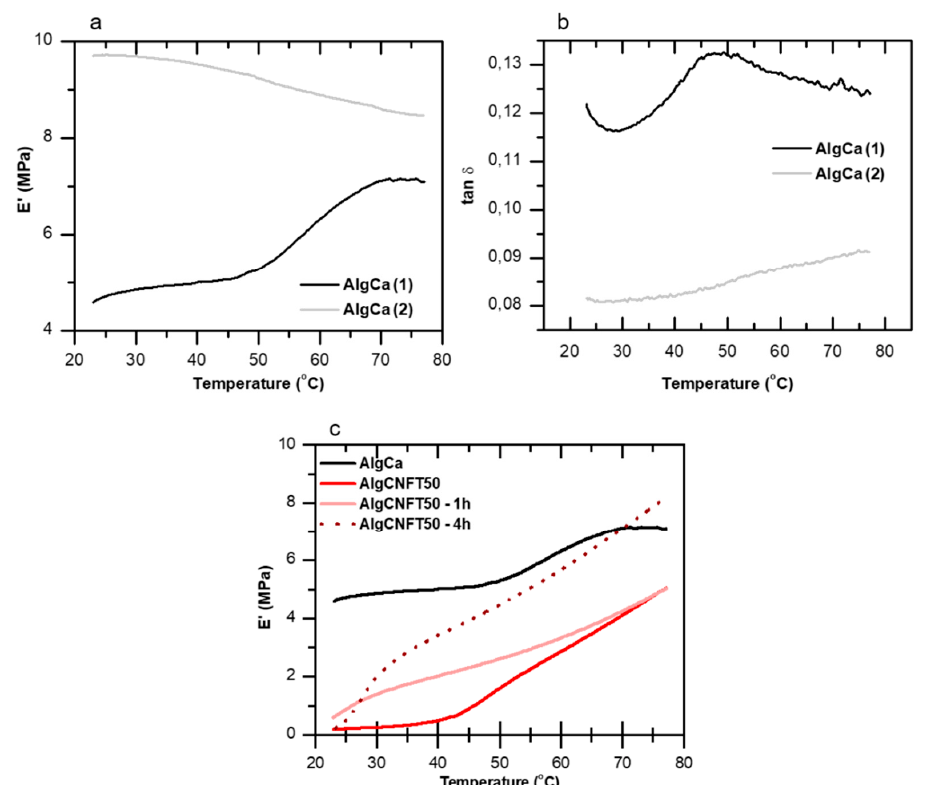
Figure 5. Dynamic mechanical thermal analyses of alginate-gels. Changes of ( a ) storage moduli (E’) and ( b ) tan δ for alginate gel without nanocelluloses addition (AlgCa) during two heating cycles. ( c ) Influence of thermal post-treatment on the samples carried out in an oven at 60 °C for 0, 1 or 4 h for alginate gels at 50 wt % concentration of TEMPO-oxidized cellulose nanofibers (AlgCNFT).